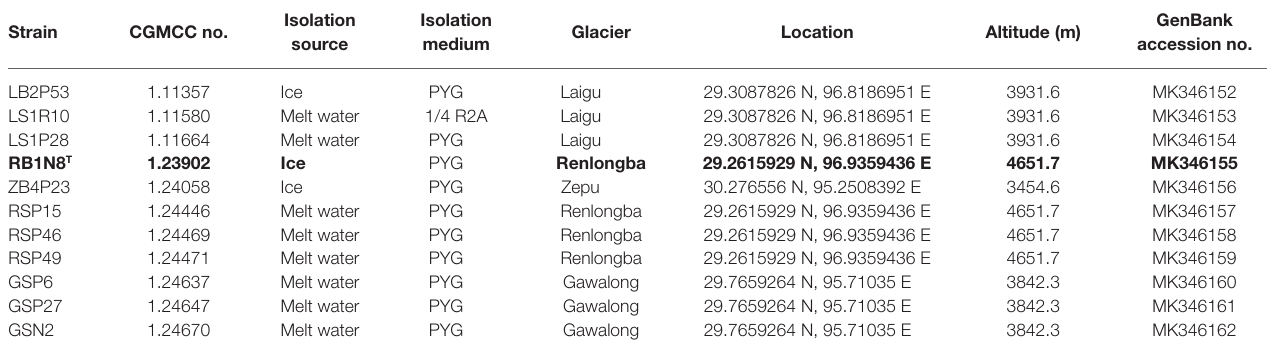
TABLE 1 | Information of the Flavobacterium strains analyzed in this study and GenBank accession nos. of the 16S rRNA gene. Strain CGMCC